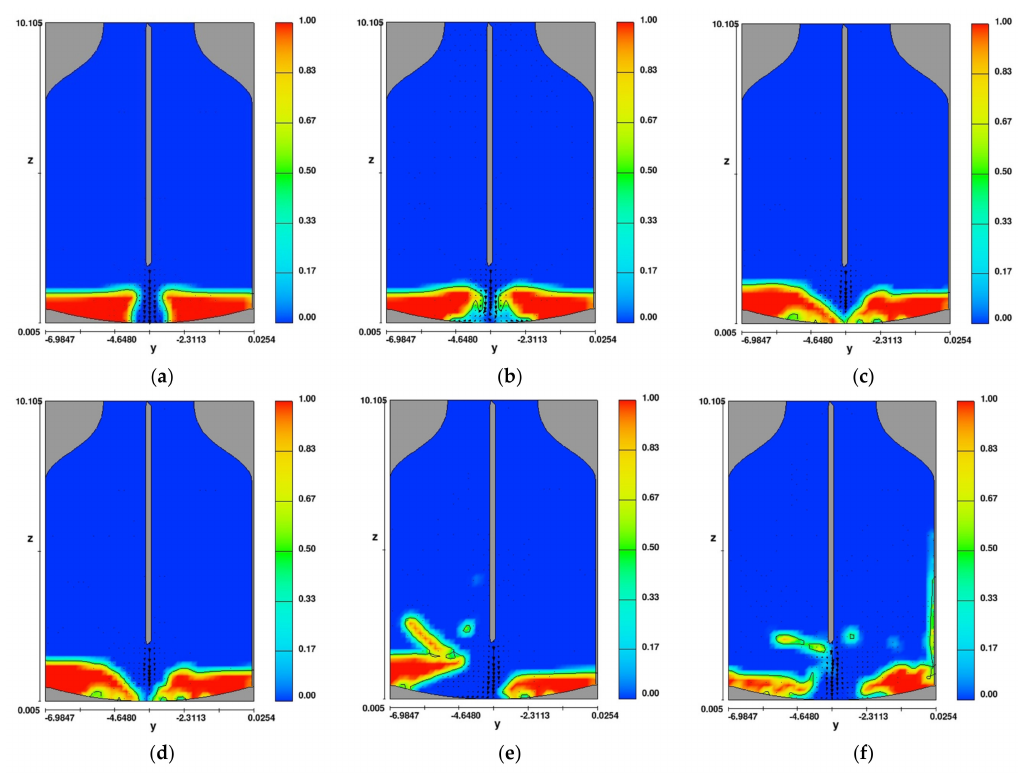
Figure 9. Distribution of liquid phase for variant 1 after time ( a ) 0.05 s, ( b ) 0.1 s, ( c ) 0.45 s, ( d ) 0.5 s, ( e ) 1.5 s, and ( f ) 2.5 s.